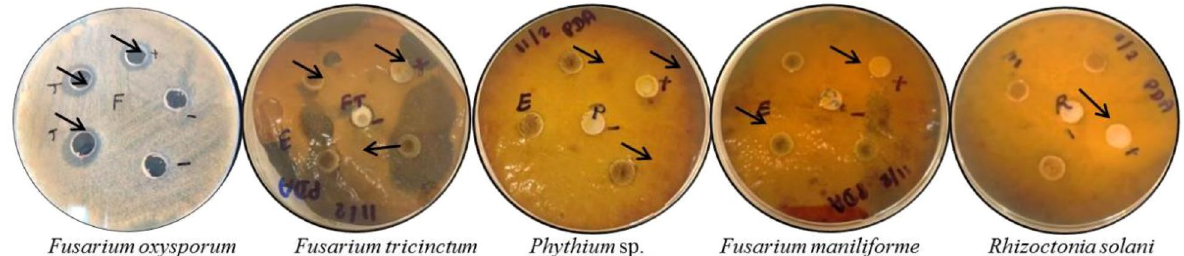
Figure 6. Antifungal zone of inhibition by iron oxide (Fe 3 O 4 ) nanoparticles (From left to right) Fusarium oxysporum, Fusarium tricinctum, Phythium sp. Fusarium maniliforme, and Rhizoctonia solani .